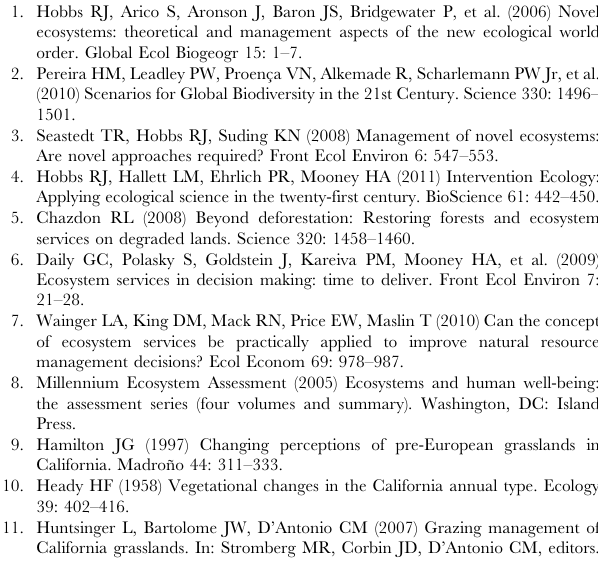
Figure S2 Plot of the residuals for the linear mixed effect model analyses of Shannon diversity. Table S1 Results for main effects of linear mixed effect models (F-values, t-values for orthogonal contrasts { ) of the effects of manipulating grazing intensity on ecosys- tem functions measured in three different experimen- tally established species assemblages in California grasslands. Table S2 Mean and range of ecosystem services measured in three experimentally established species assemblages in California grasslands in response to manipulation of grazing